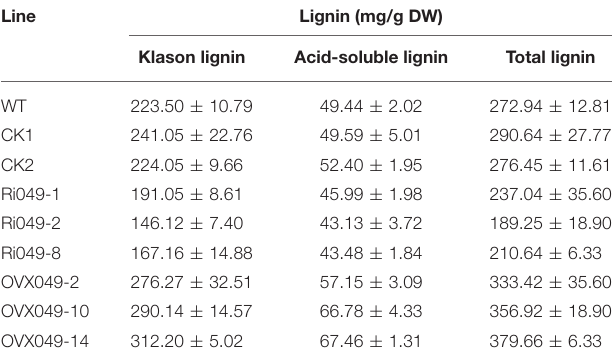
TABLE 1 | Lignin contents in the Ii049 transgenic lines.